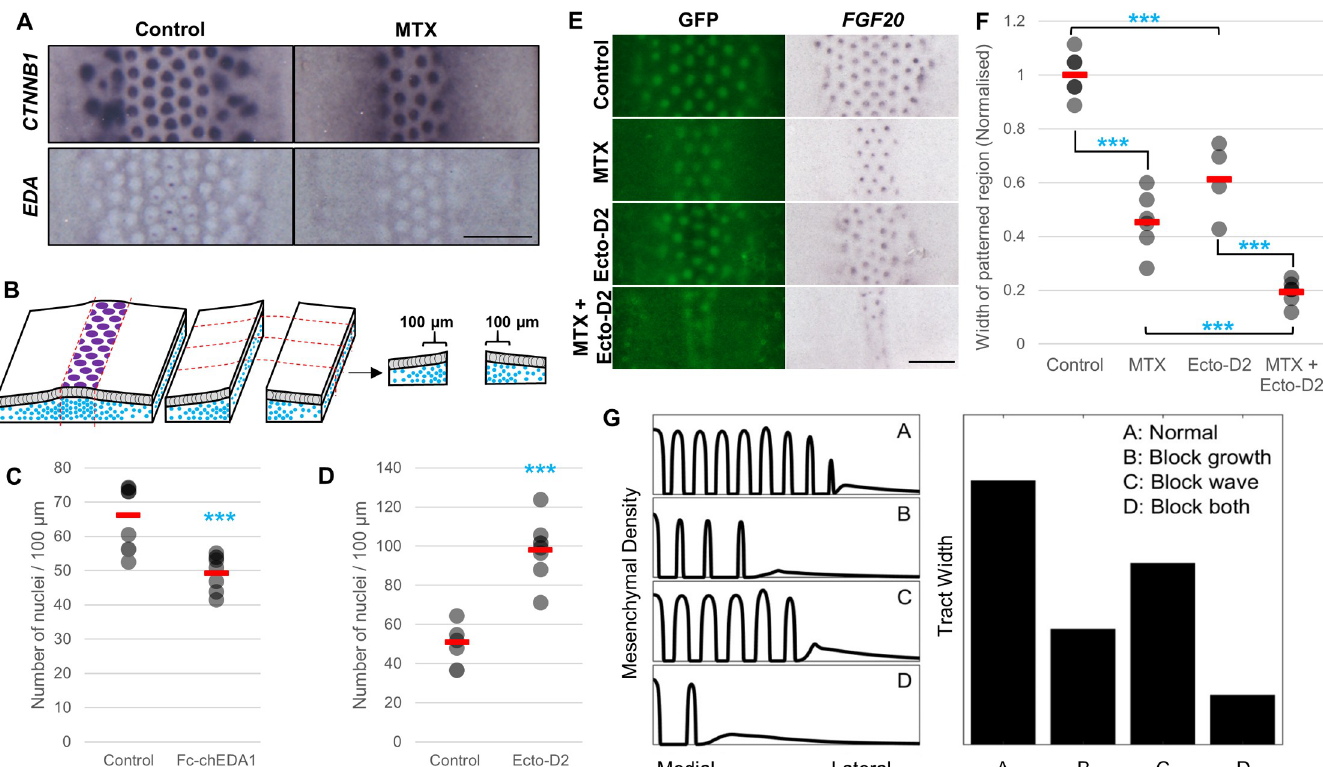
Fig 5. Mesenchymal cell density and EDA signalling interact during skin patterning. (A) E6.5 skin cultured for 48 hours in 5 μ M MTX, an inhibitor of cell proliferation. Primordium formation is detected by CTNNB1 expression. Inhibition of cell proliferation reduces the width of the patterned region, but the extent of the EDA expression wave is unaffected. Scale bar: 2 mm. (B) Schematic of assessment of the critical cell density at which patterning occurs. (C) and (D) Mesenchymal cell density within 100 μ m of the edge of the patterned region of skin explants in the presence of (C) an activator (Fc-chEDA1) or (D) an inhibitor (Ecto-D2) of EDA/EDAR signalling. Filled circles indicate individual data points; red bars indicate the mean. Statistical significance was calculated using a Student t test ( ��� p < 0.001). (E) E6.5 CAG-GFP skin explants cultured for 48 hours with 5 μ M MTX, 10 μ g/ml Ecto-D2, or both. Scale bar: 2 mm. (F) Quantification of patterned region widths, based on FGF20 expression, shows reduction in patterned region of cotreated samples compared to each single treatment. Statistical significance was calculated using a Student t test ( ��� p < 0.001). (G) One-dimensional representation of a simulation of the network shown in Fig 1J, with peaks representing high cell density (condensates). Reduction of the wave or of cell growth restricts the spread of pattern, whereas reduction of both has a stronger effect. The numerical values for C, D, F, and G can be found in S5 Data. E, embryonic day; EDA, Ectodysplasin A; EDAR, EDA receptor; GFP, green fluorescent protein; MTX, methotrexate.